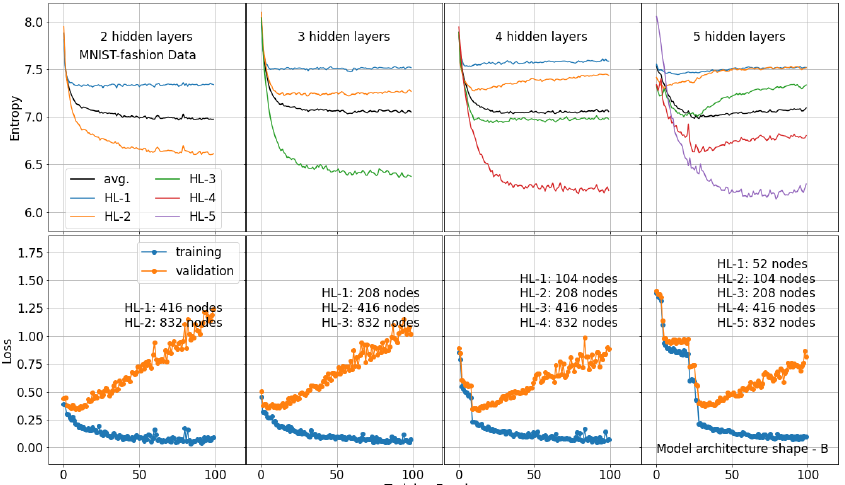
Figure A3. First row of figures show the entropy profile of four different shallow neural networks. Second row shows the corresponding training and validation losses. These models were trained using 60,000 MNIST-fashion images with 33% validation split. NLLLoss [41] was used as the loss function and the Adam optimizer [42] with learning rate 0.001 was used for the model optimization.